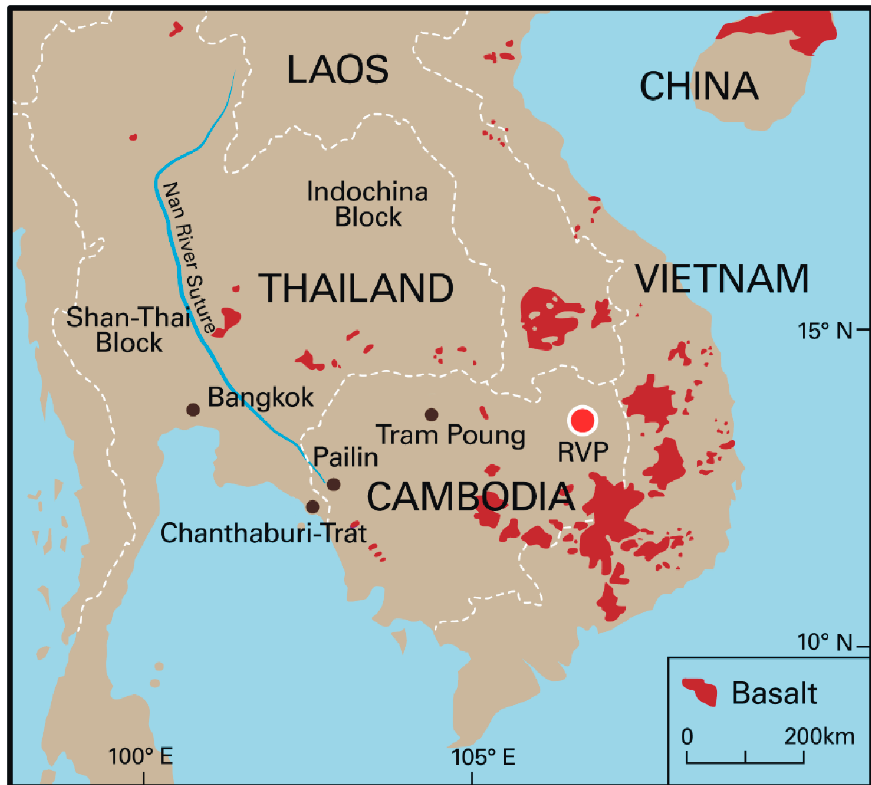
Figure 3. Distribution of Cenozoic alkali basalt provinces (red) in SE Asia (modified after [16] ). The location of the Ratanakiri Volcanic Province (RVP) is shown as a red circle.